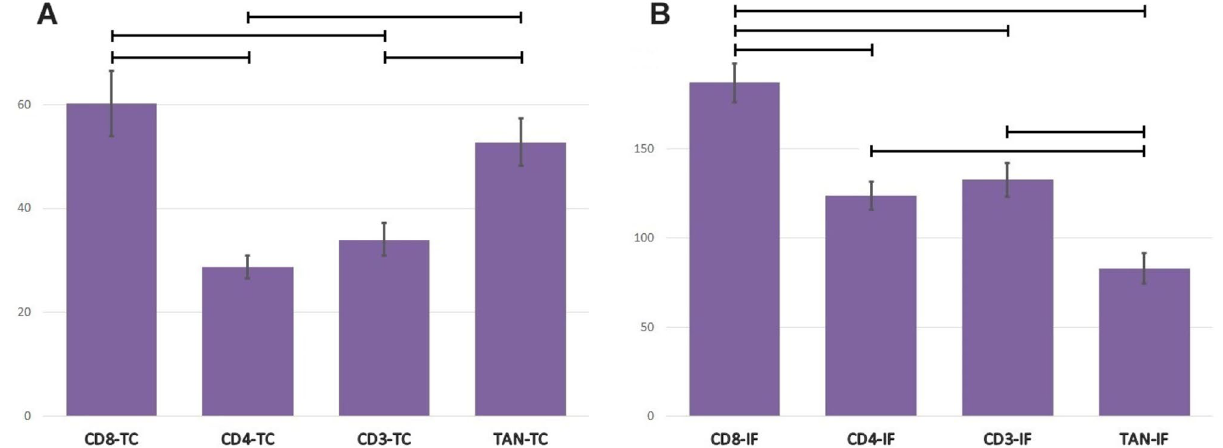
Figure 2. ( A ) Tumor-infiltrating immune cells density in tumor center. Data are presented as means and standard errors. Horizontal lines indicate significant differences at p < 0.05. ( B ) Tumor-infiltrating immune cells density in invasive front. Data are presented as means and standard errors. Horizontal lines indicate significant differences at p < 0.05. CD8 TC CD8 IF